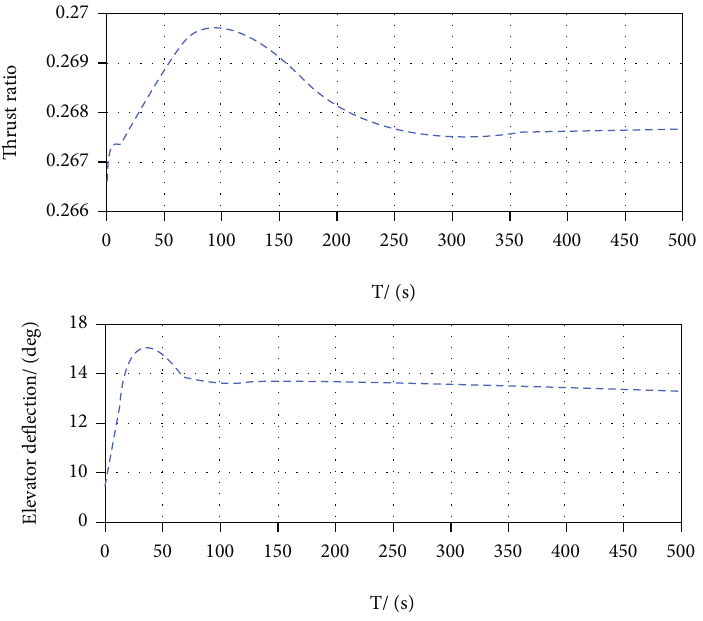
Figure 9: Control